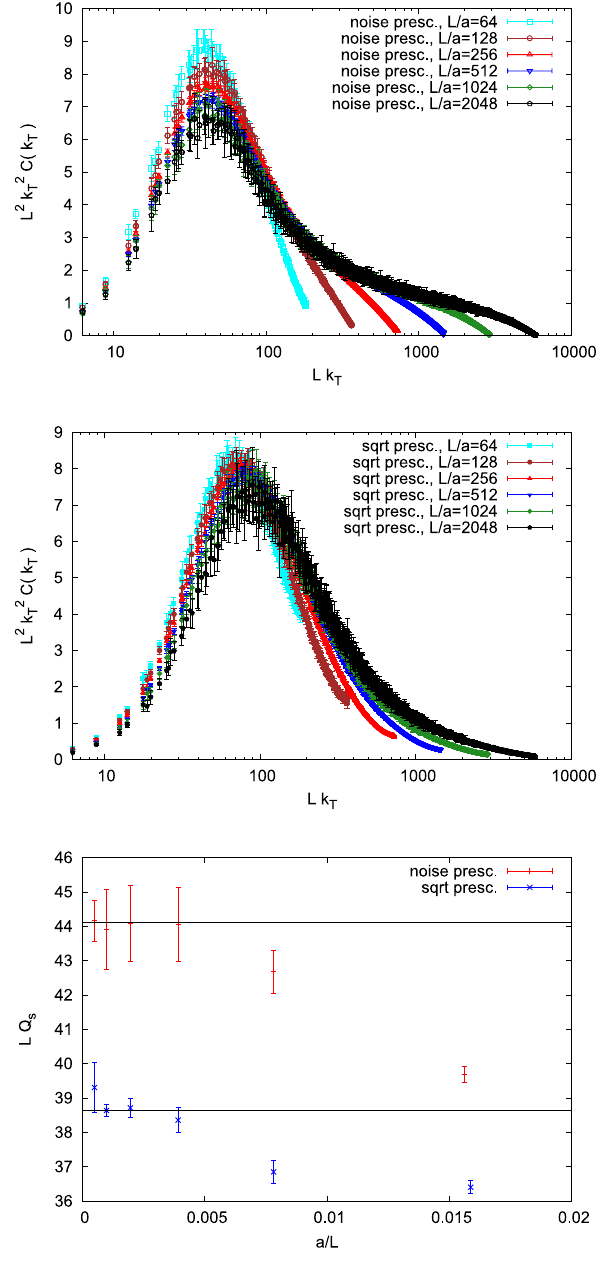
Fig. 13 Comparison of gluon densities obtained with the “noise” (top) and “square root” (middle) prescriptions for α s as a function of the volume at rapidity s = 0 . 16. Bottom: infinite volume extrapolation of thesaturationscale Q s determinedfromthemaximaofthedistributions. We use a constant fit ansatz of the form LQ s ( a / L ) = b with b being fit parameters, where the fitted data include the 4 largest volumes. In order to contain both sets of data on the same plot, the “square root” data are shown for a twice smaller rapidity, s = 0 . 08. For volumes L / a ≥ 256, a constant extrapolation to the infinite volume limit describes the data